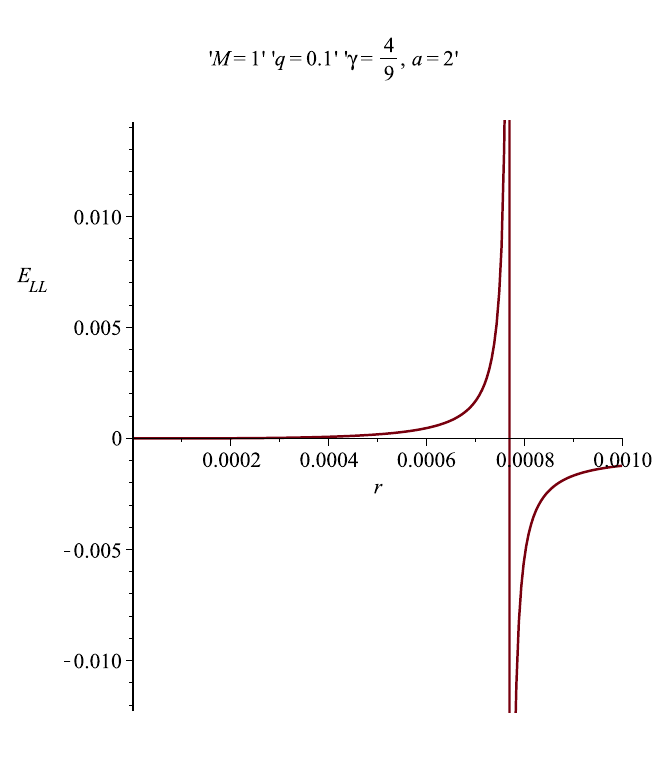
Figure 11. Landau-Lifshitz energy versus the radial distance r near the origin.